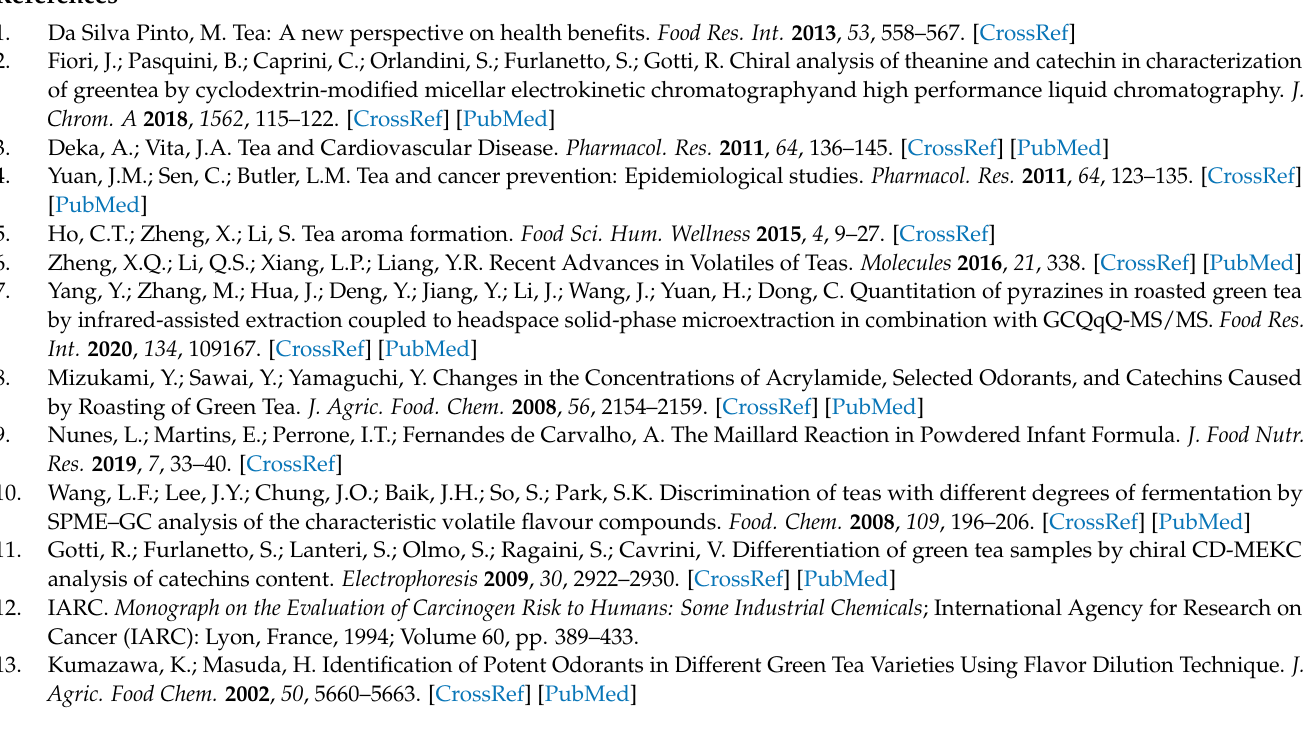
Figure S1. HS-SPME optimization. (A) Effects of the fibre extraction efficacy on the peak area of six representative VFCs. HS-SPME Conditions: sample 1 mL of tea infusion, extraction time 20 min, temperature 100 ◦ C, stirring rate 400 rpm. The applied GC-MS conditions are described in the Experimental section. Effects of HS-SPME equilibration time (B), extraction time (C) and temperature (D) on the peak area of three representative VFCs. HS-SPME Conditions: sample 1 mL of tea infusion, variable extraction time and temperature, stirring rate 400 rpm. The applied GC-MS conditions are described in the Experimental section. Figure S2. TIC chromatograms on ZB5 column of a representative tea (Bancha) before (A) and after (B) roasting. Chromatographic conditions: initial 40 ◦ C (hold time: 1 min), then ramped by 3 ◦ C/min to 220 ◦ C (hold time: 10 min), helium gas flow rate 1